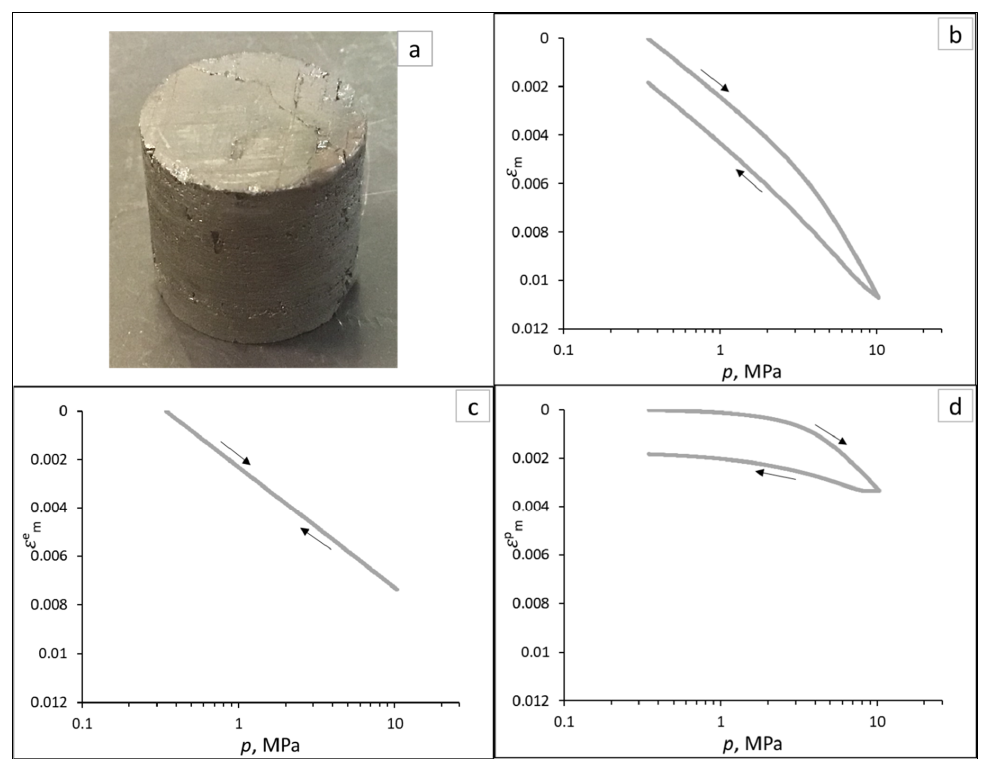
Figure 19. Photo and calculation of coal sample 2 (test 2).